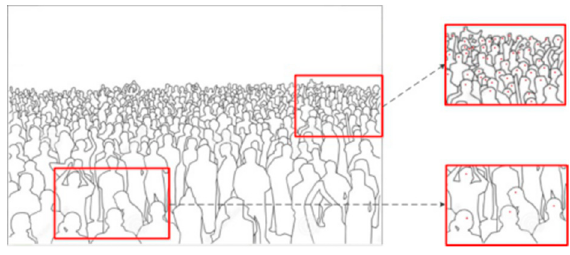
Figure 3. Camera perspective effect.